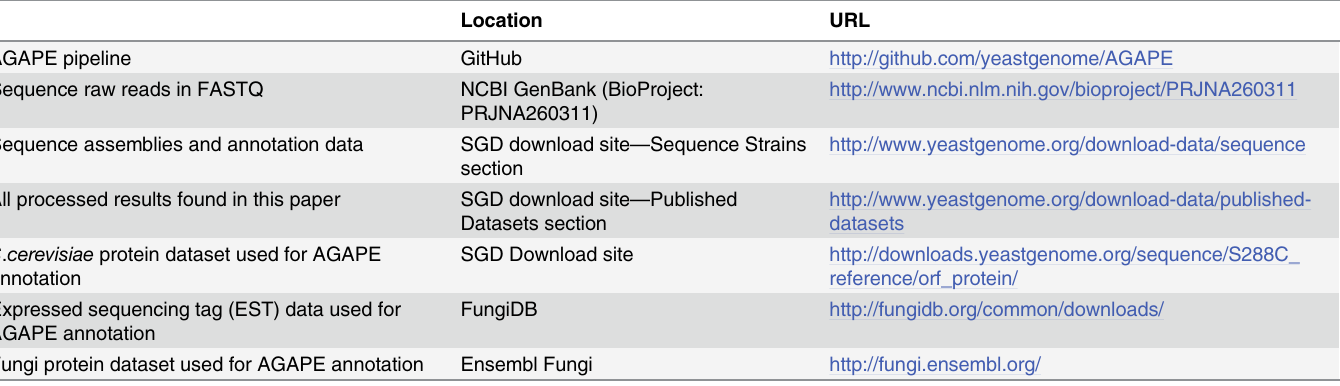
Table 1. Location for the data, the software pipeline, and resources required for setting up the